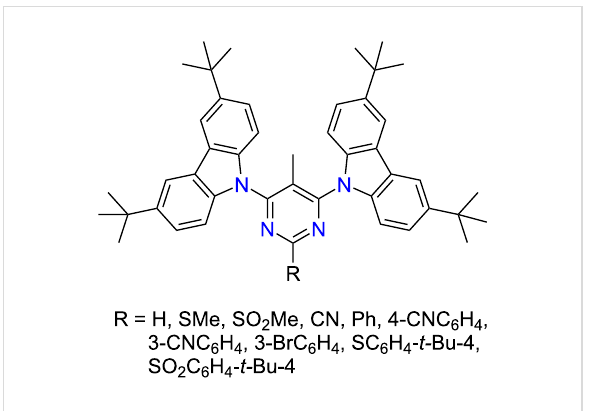
Figure 1: 2-Modified 4,6-bis(3,6-di- tert -butyl-9 H -carbazol-9-yl)-5-